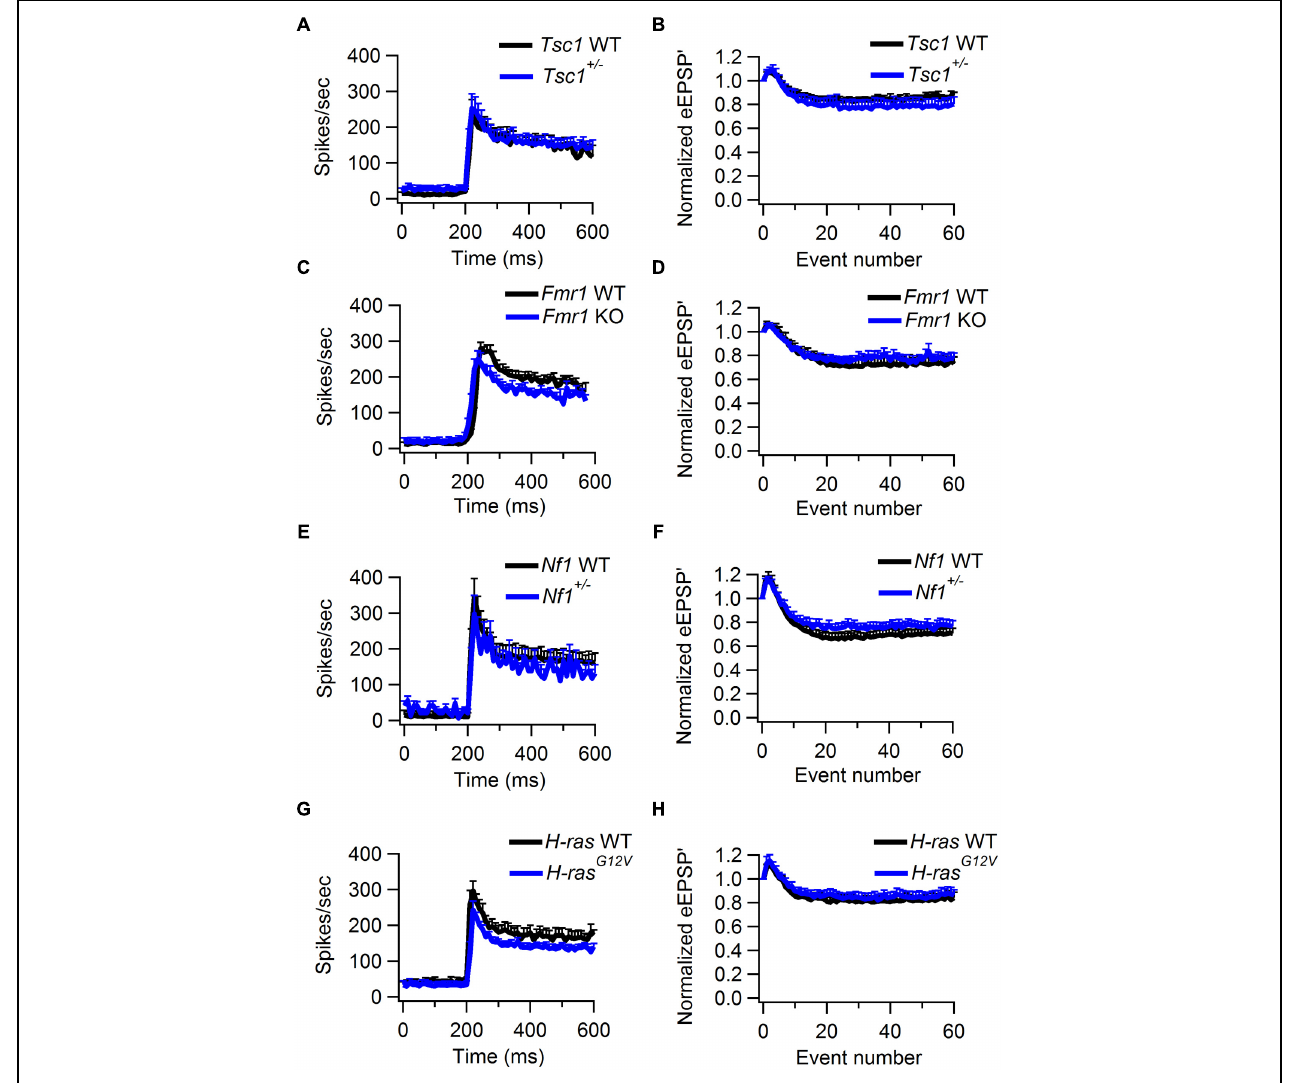
FIGURE 5 | Sound-evoked STD in WT and Tsc1 + / − , Fmr1 KO, Nf1 + / − , and H-ras G 12 V mutant mice. (A) Average peristimulus time histogram from WT (black) and Tsc1 + / − mutants (blue). Error bars indicate SEM. (B) Normalized average of the amplitude of eEPSP’ against sound-evoked